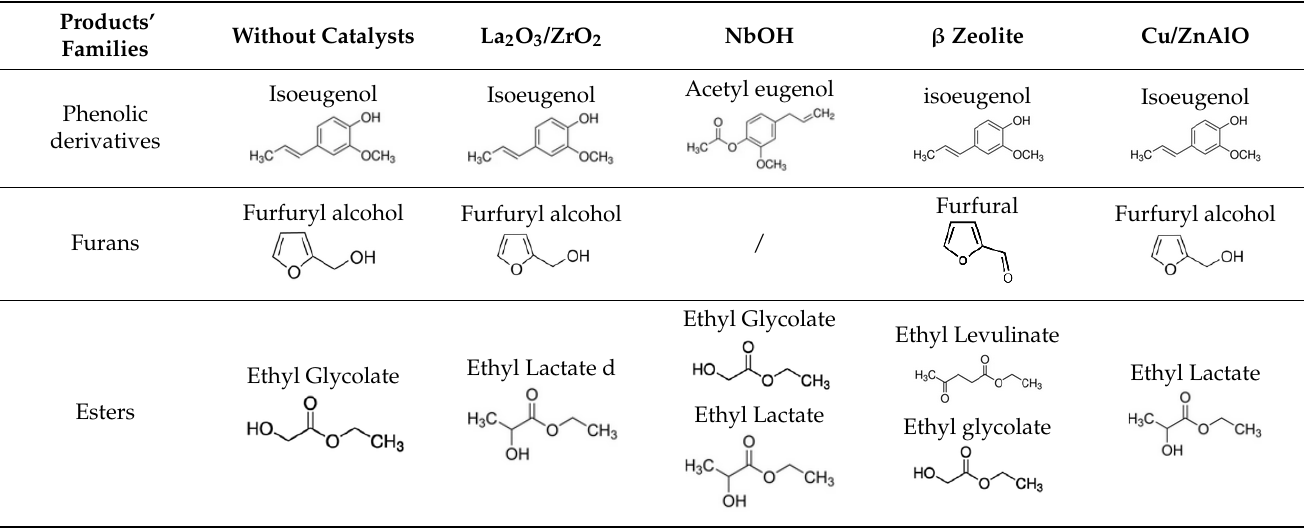
Table 3. Pine wood fractionation in SC ethanol: nature of the main light liquid products as a function of catalysts addition. Fractionation of pine in SC ethanol at 250 °C. Conditions: Batch reactor, pine 2.5 g, catalyst 1 g, ethanol 27 g, 1 h at 250 °C.